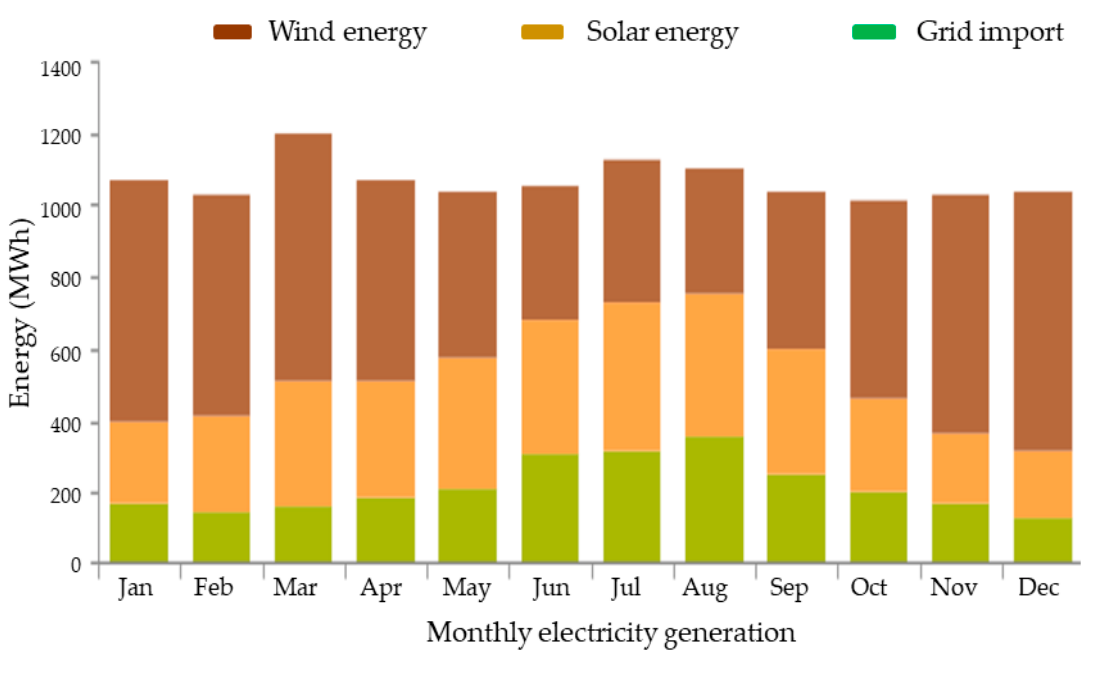
Figure 8. Monthly electricity production by renewable sources and grid imports.